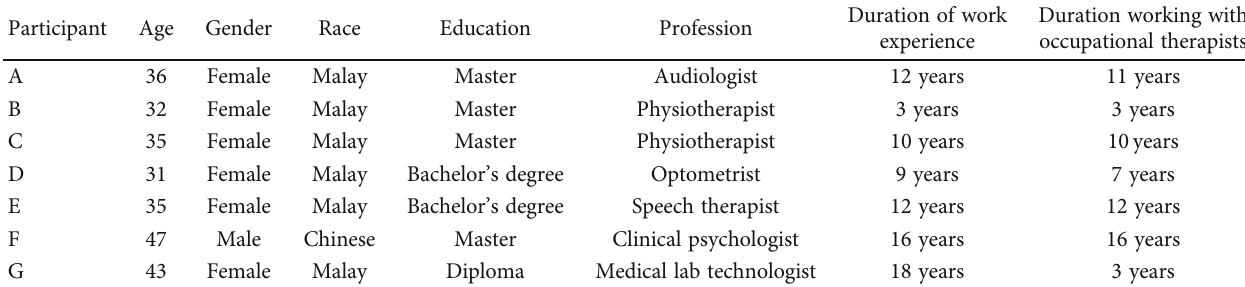
Table 1: Characters of the participants ( N = 7